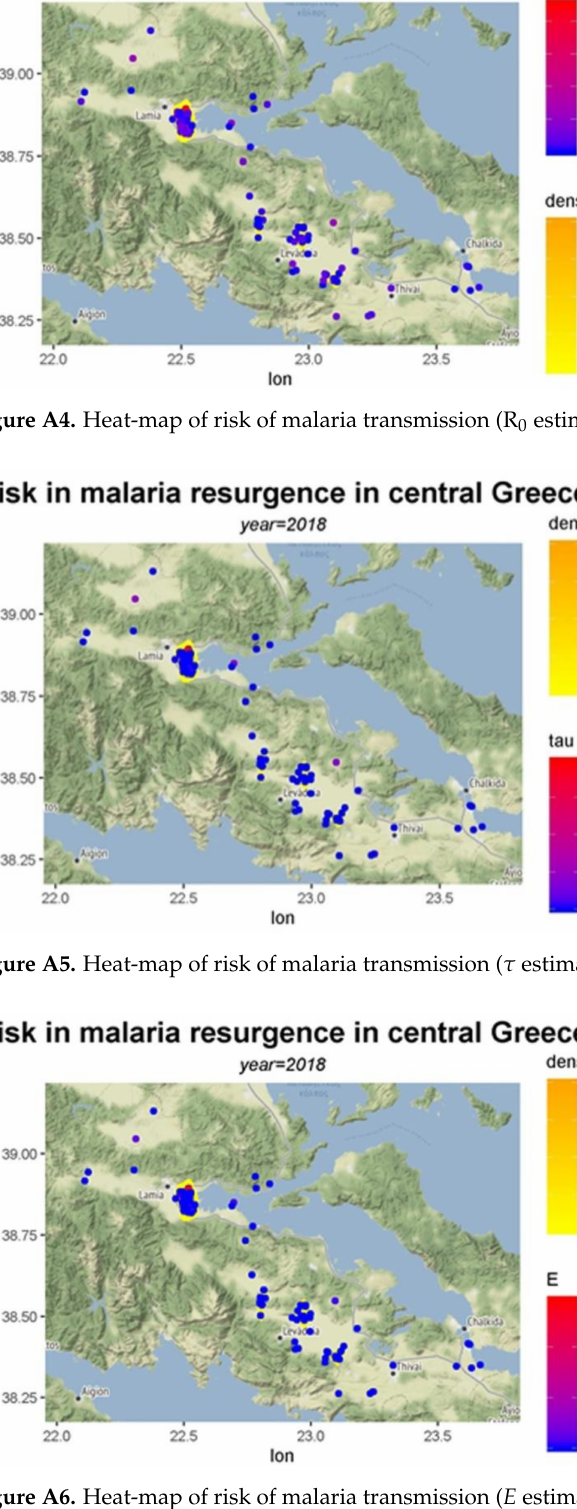
Figure A6. Heat-map of risk of malaria transmission ( E